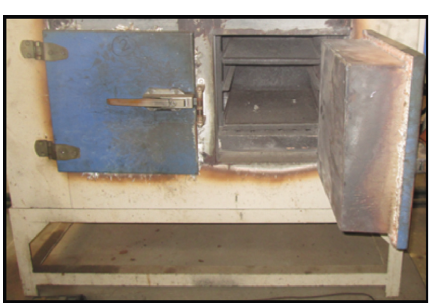
Figure 3: Sintering process.